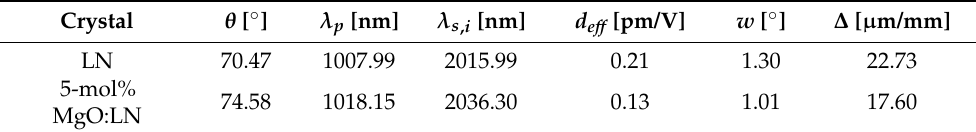
are 0.21 pm/V for a LN and 0.13 pm/V for a MgO:LN as shown in Figure 5a. Over the